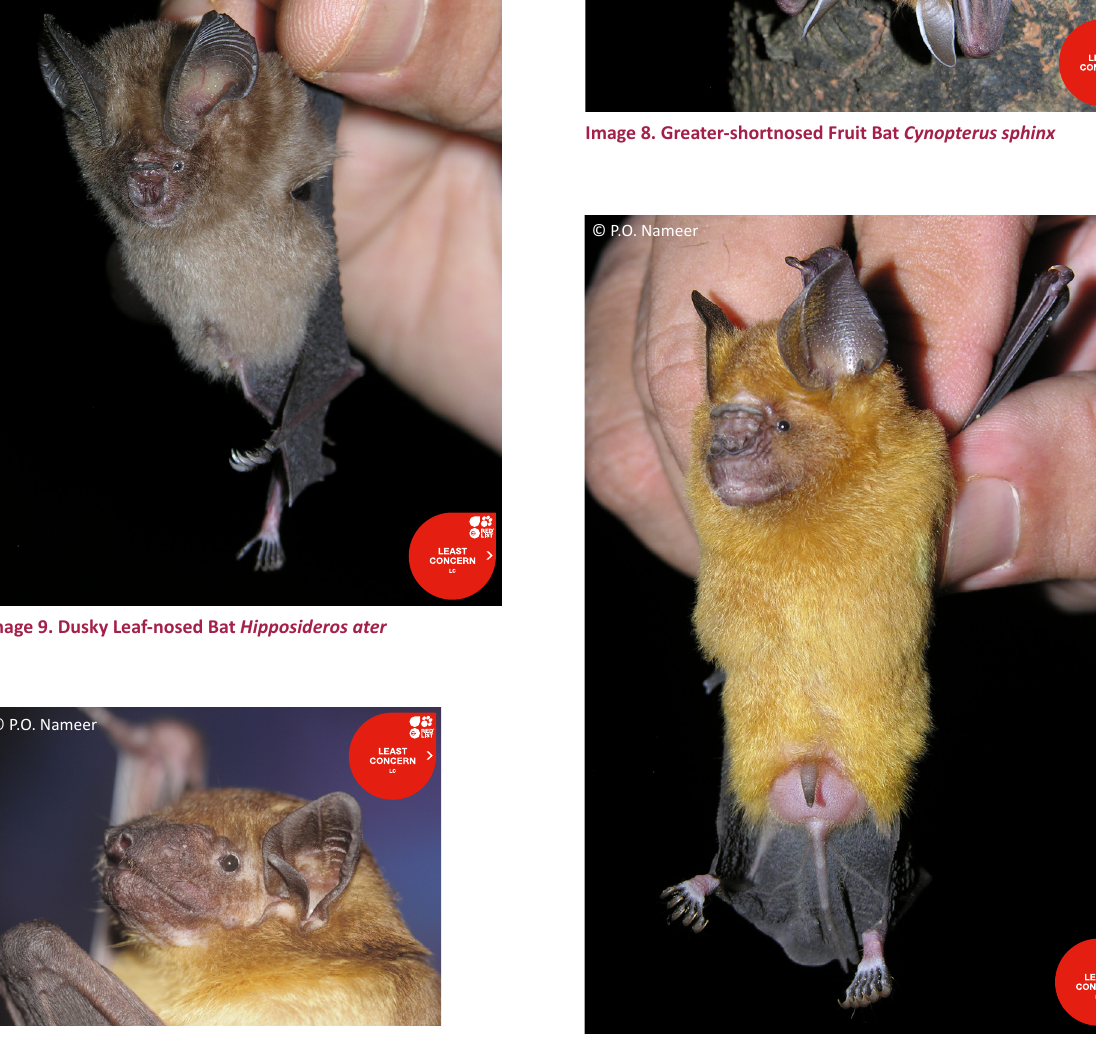
Image 11. Fulvus Leaf-nosed Bat Hipposideros fulvus